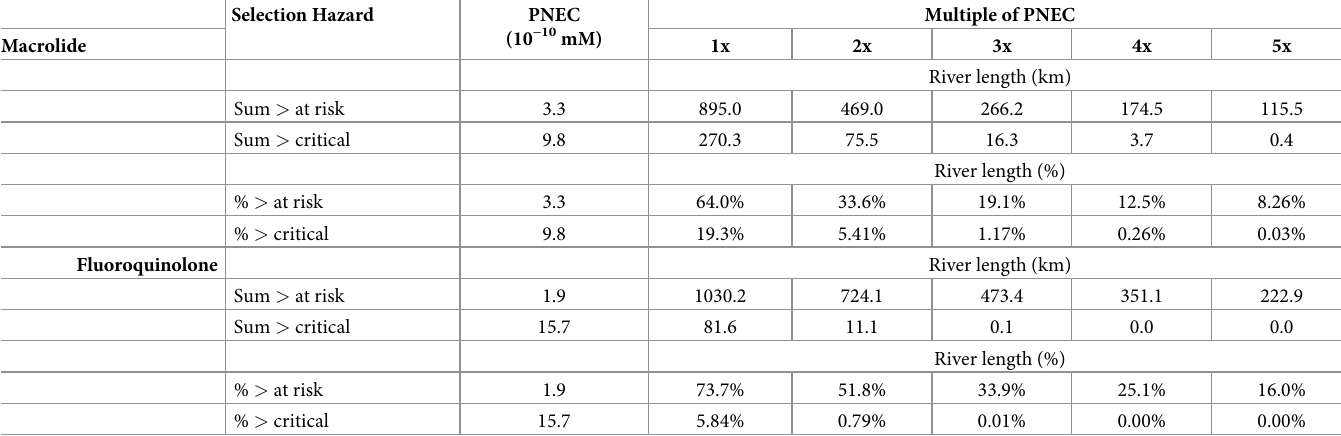
Table 7. Sum and fractional river length exceeding the PNEC and multiples of the PNEC for macrolides and fluoroquinolones. Selection Hazard